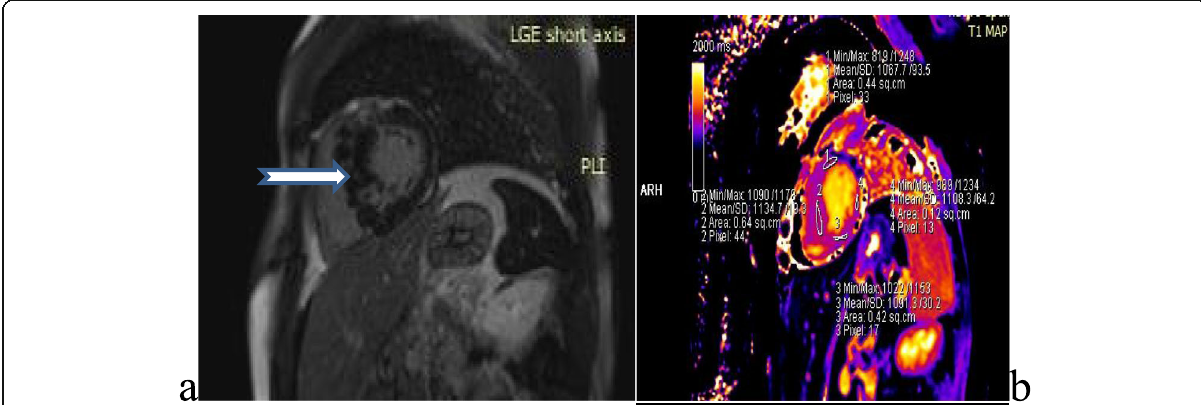
Fig. 2 Sixty-year-old man with septal hypertrophic cardiomyopathy and septal fibrosis. a Late gadolinium enhancement (LGE) was found in the interventricular septum (arrow). b Non-contrast-enhanced T1 mapping shows that the native T1 value of the septal region including LGE is 1134 ms, which is more than 1070